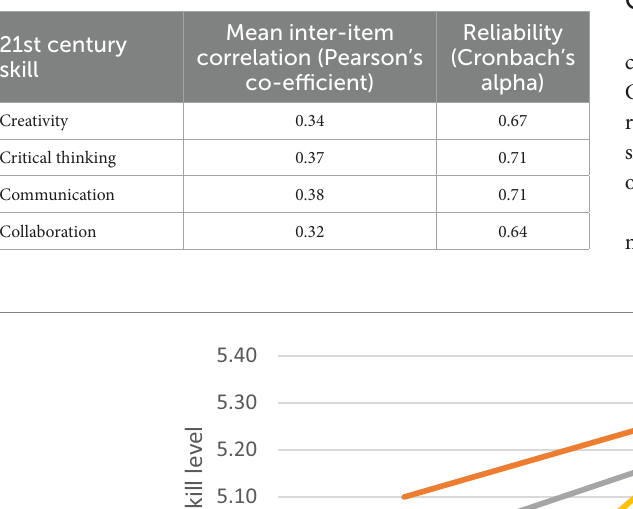
TABLE 2 21st Century Skills Scale correlations and